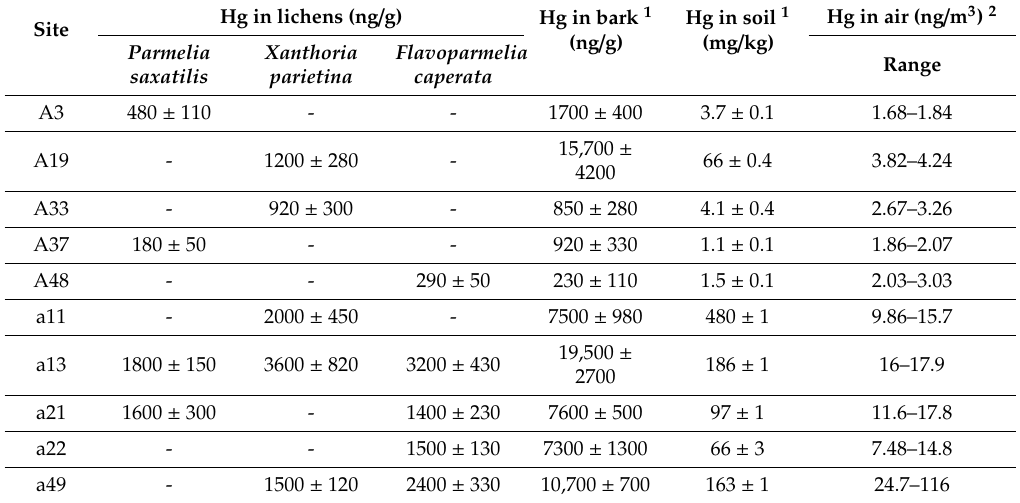
Table 1. Data of Hg contents in lichens (this study) in tree barks, soils, and Hg ◦ in air (literature data). Hg in lichens (ng / g) Hg in bark Site